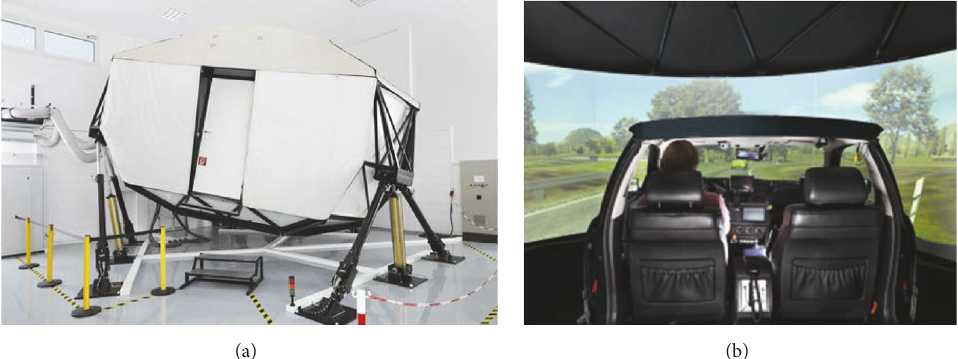
Figure 1: The WIVW dynamic driving simulator. Hexapod movement system (a) and simulator interior with vehicle mock-up and video projection